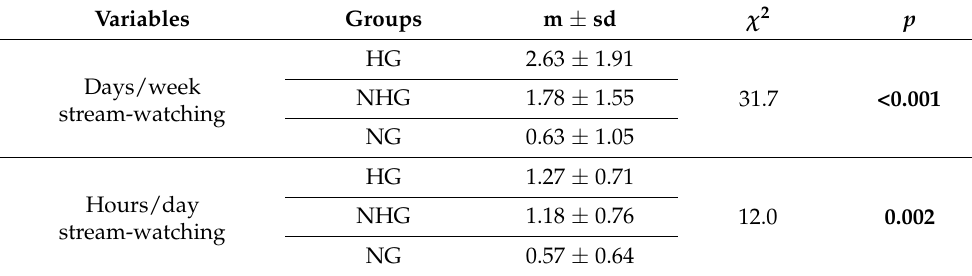
Table 1. Frequency per week and hours per day of stream-watching in the three groups. Variables